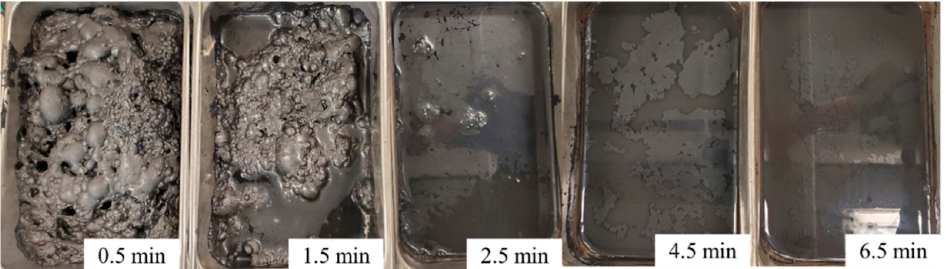
Figure 6. Foam changes for different flotation times: MIBC dosage, 120 g/t; kerosene dosage, 500 g/t; agitation speed, 1200